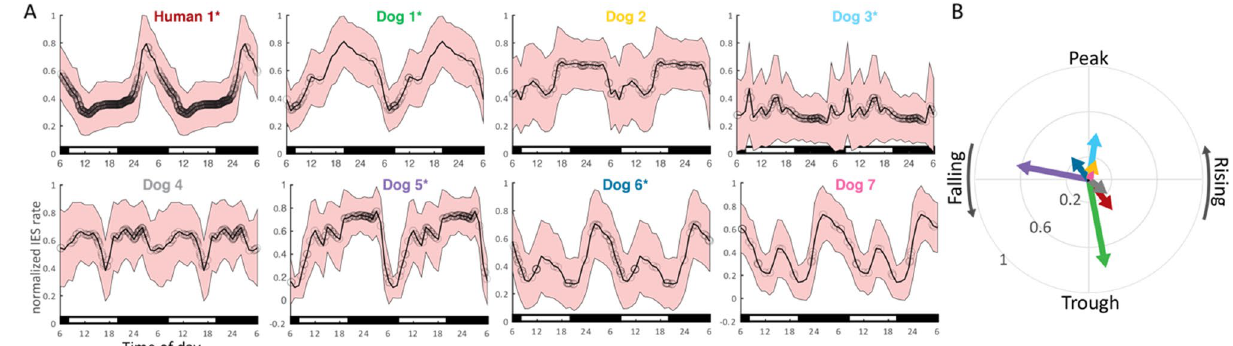
Figure 3. Circadian IES rate and seizure cycles. ( A ) Average normalized daily IES rate, with superimposed seizure onset (black circles) relative to clock time. Six hundred and twenty seven total seizures. To aid visualization two periods of the averaged cycle are displayed. Day/night periods are indicated by white/black bars at the bottom of each plot. Ultradian IES rate cycles are evident as minor daytime peaks in the canines and are most clearly seen in Dogs 6 and 7. The human subject has a pronounced nocturnal IES peak. ( B ) Seizure phase locking to the circadian IES rate cycle. Five subjects had significant seizure phase locking to the circadian spike rate cycle (marked by ‘*’ next to the subject identifier in ( A )). There was no clear group level phase preference of seizure timing relative to the circadian spike rate